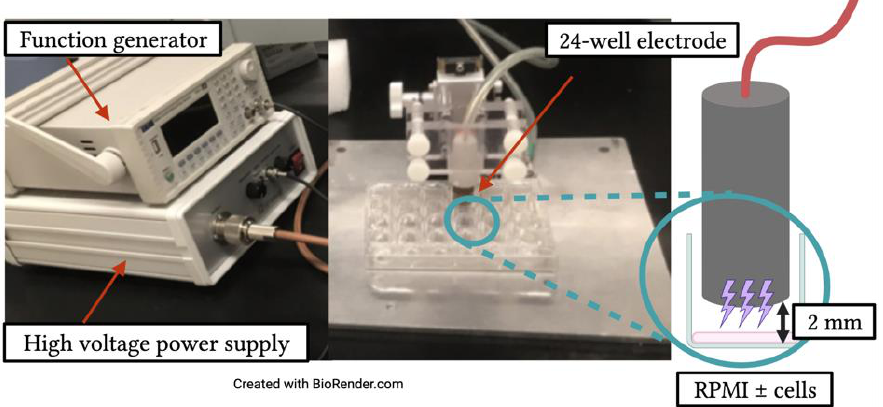
Figure 1. Experimental set-up for exposure of RPMI, Jurkat cells, or THP-1 cells to NTP. A nanosecond-pulsed dielectric barrier discharge (DBD) device was used to deliver NTP to cells or RPMI aliquoted into a 24-well plate. Plasma generation frequency (30–105 Hz) was controlled through the function generator, which was set to deliver a 10 s exposure time. NTP was delivered to cells using a dielectric-encased electrode positioned by a Z-positioner over media in the absence or presence of cells at a distance of 2 mm from the bottom of the well.